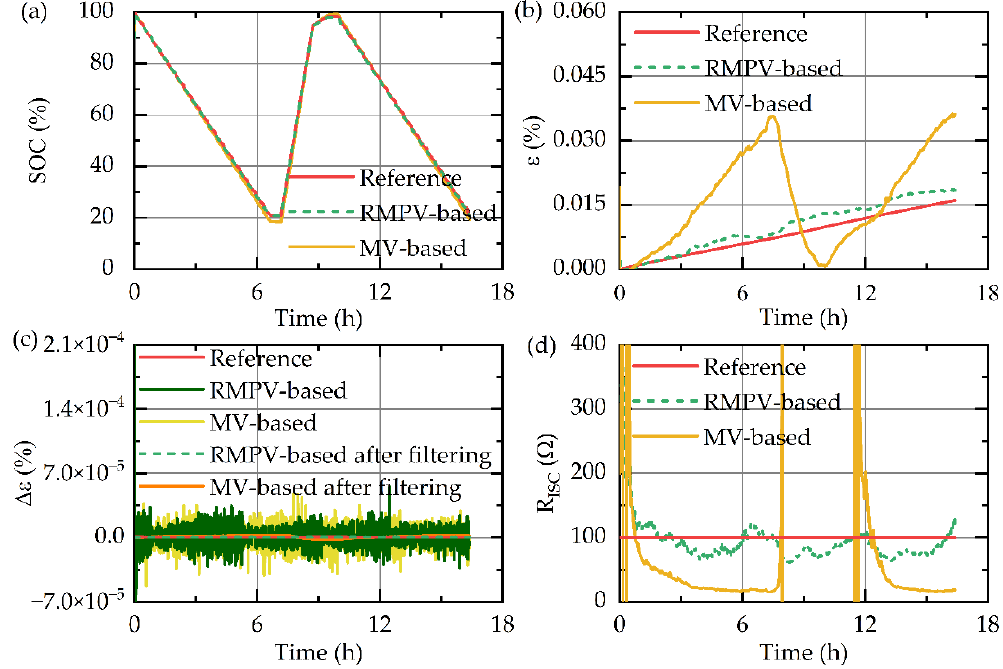
Figure 8. Estimation results during the 100 Ω -ER test: ( a ) SOC estimation result; ( b ) estimation result of ε; ( c ) estimation result of Δε; ( d ) R ISC estimation result.